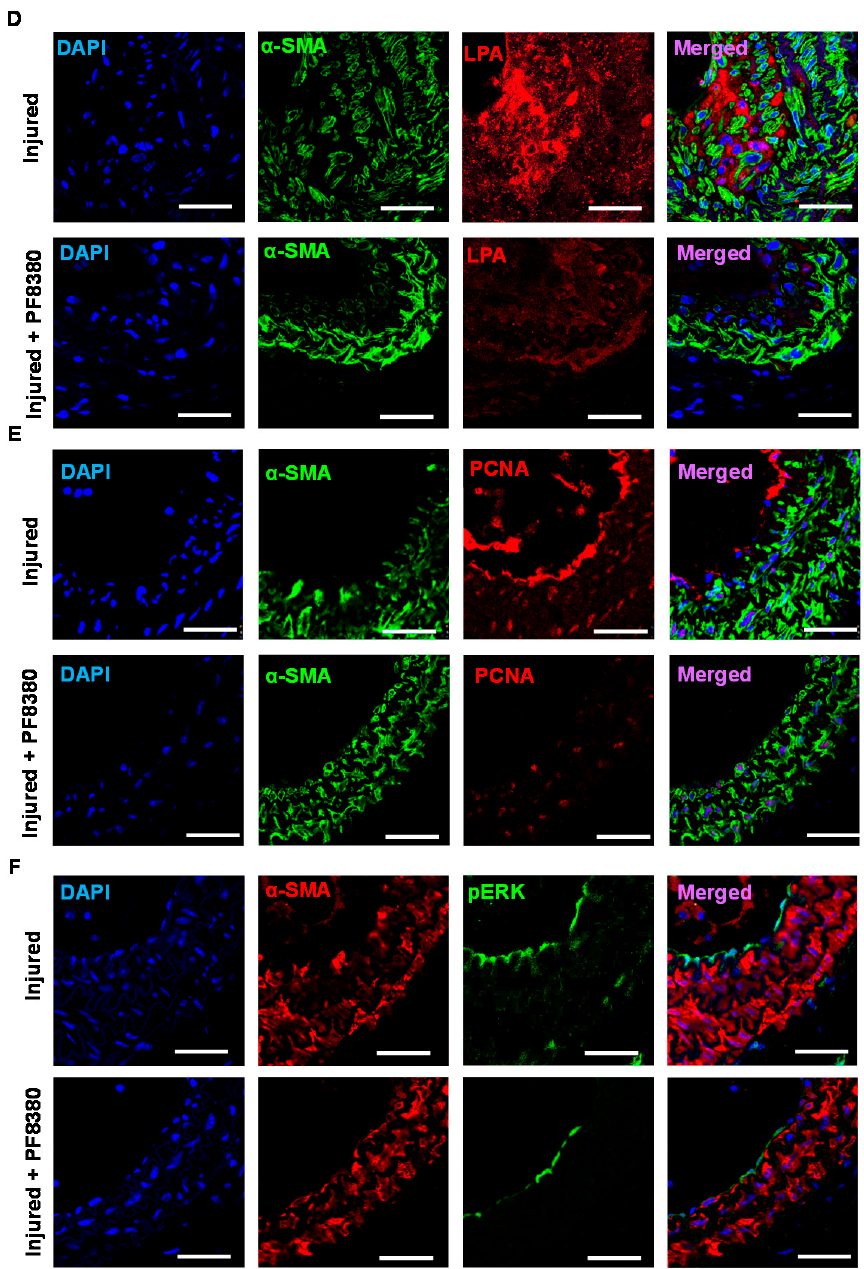
Figure 6. Treatment with the ATX inhibitor rescues neointimal hyperplasia. ( A ) Hematoxylin and eosin staining sections of the injured carotid artery with and without PF8380 treatment at 4 weeks after injury. Scale bar = 50 µ m. ( B ) Quantifying luminal area and I/M ratio with and without PF8380 treatment at 4 weeks after injury. ( C ) Carotid tissue LPA levels with and without PF8380 at 3 weeks after injury. ( D ) Mouse carotid artery stained for LPA with and without PF8380 treatment at 4 weeks after vascular injury. Scale bar = 10 µ m. ( E ) Immunofluorescence staining for PCNA in injured carotid arteries with and without PF8380 treatment at 4 weeks after vascular injury. Scale bar = 10 µ m. ( F ) Immunohistochemistry for phospho-ERK in injured carotid arteries with and without PF8380 treatment at 4 weeks after vascular injury. Scale bar = 10 µ m. All values are mean SD ( n = 3) ± compared to the uninjured vessel using the Mann–Whitney U test. LPA—lysophosphatidic acid; LPAR—lysophosphatidic acid receptor; ATX—autotaxin; PCNA—proliferating cell nuclear antigen.